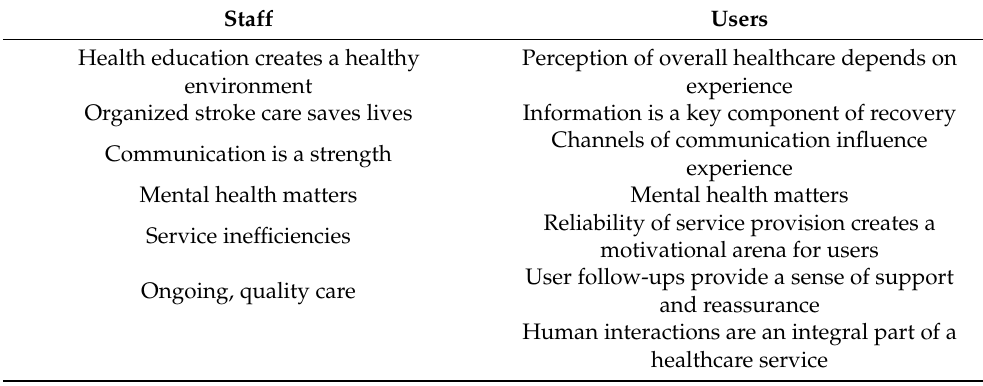
Table 3. Organizing themes from interview